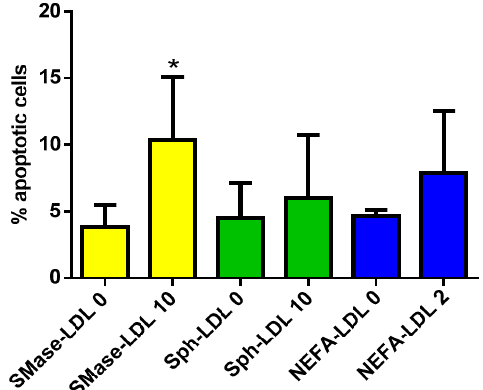
Figure 8. Total apoptosis induced by modified LDL(–). Total apoptosis induced by LDL modified by SMase treatment (yellow bars), Sph (green bars), or non-esterified fatty acid (NEFA) enrichment (blue bars), as described in the Methods section. Results are expressed as mean ± SD ( n = 5), * vs. unmodified LDL, p < 0.05.